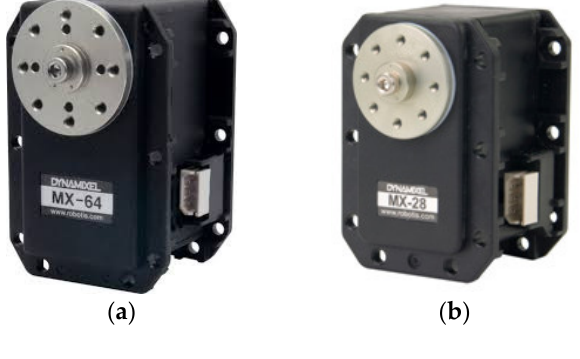
Figure 10. ( a ) MX—64; ( b ) MX—28.